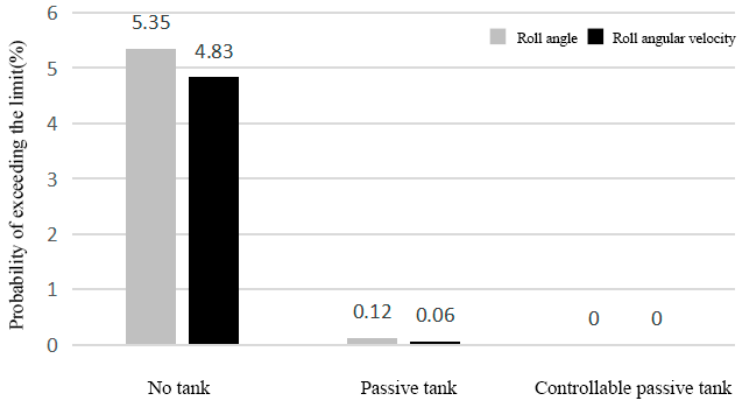
Figure 14. Probability of ship’s roll angle and roll angular velocity exceeding the limit.